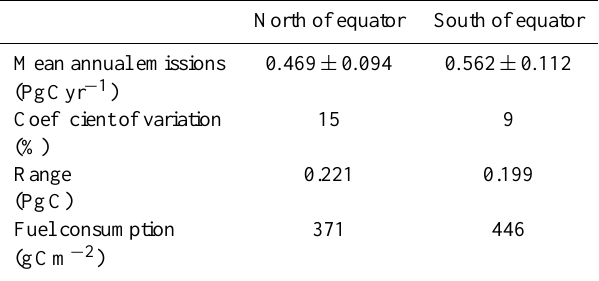
Table 8. Fire emissions characteristics for Africa based on